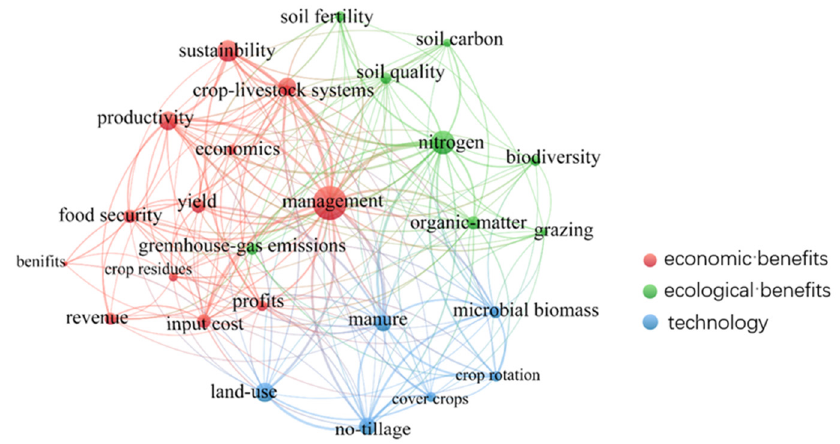
Figure 3. A map of the spread of keywords for the WOS database.